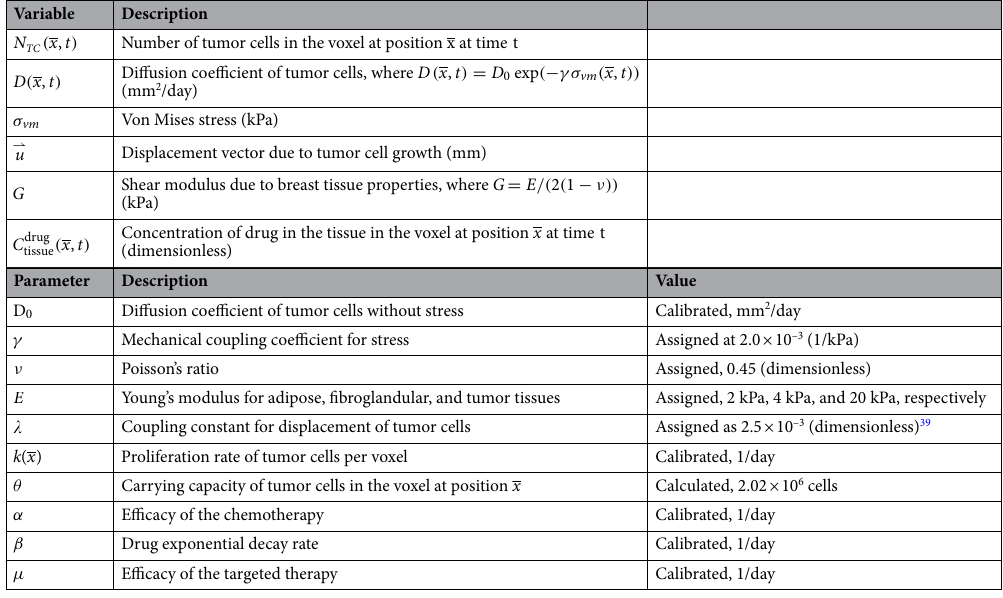
Table 1. Description of the variables and parameters for the model system including the assigned parameter values and specification of